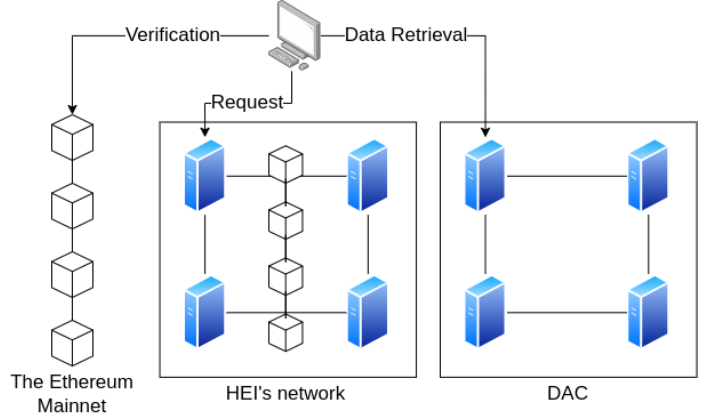
Figure 8. The connections in the recommended